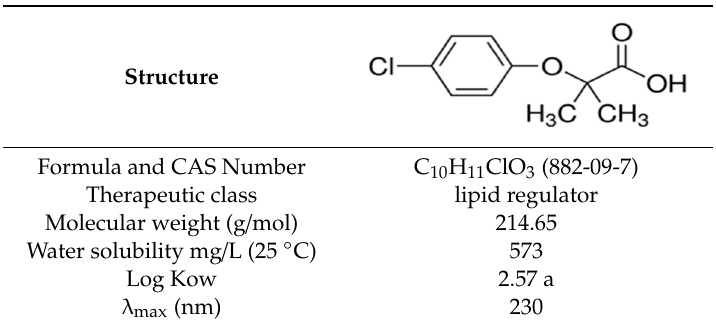
Table 1. Physicochemical properties of clofibric acid.